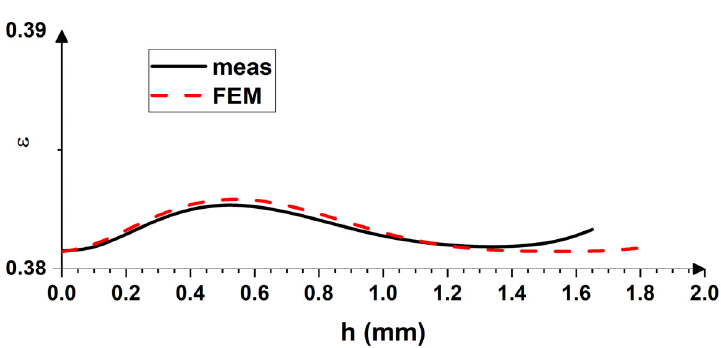
Figure 14. Distribution of equivalent strain across the thickness of symmetrically rolled sheet.